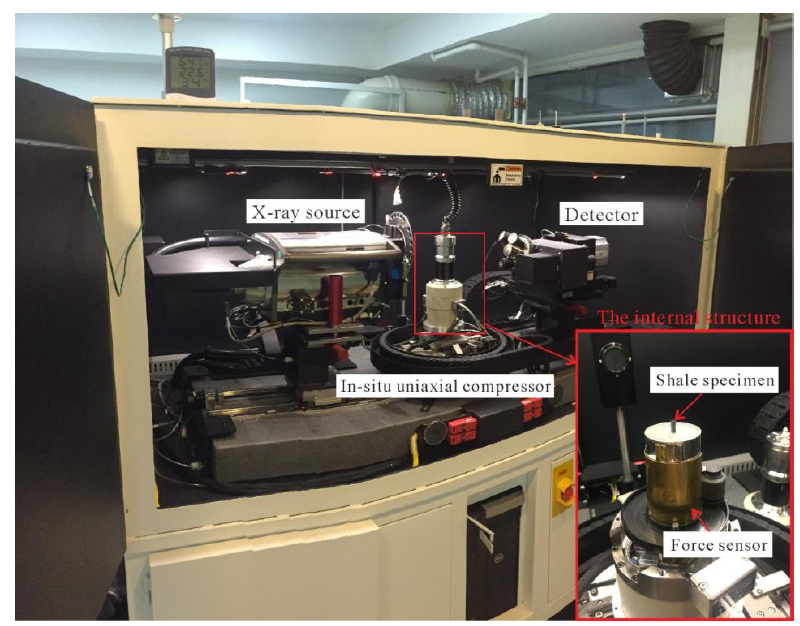
Figure 1. X-ray CT and compression stage.